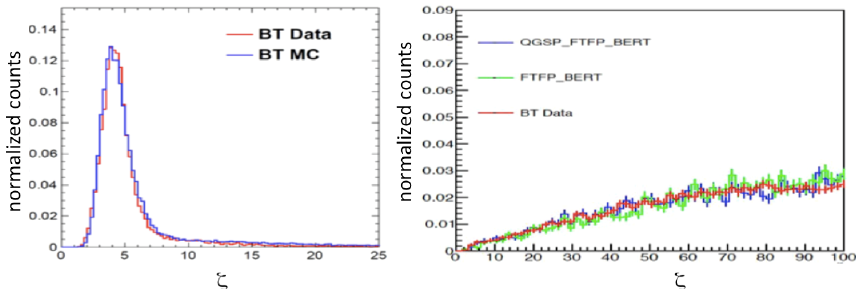
Figure 8. Beam test - The ζ -distributions for electrons (left panel) and for protons (right panel). In the proton plot the real data are compared with simulations based on di ff erent models of the hadronic